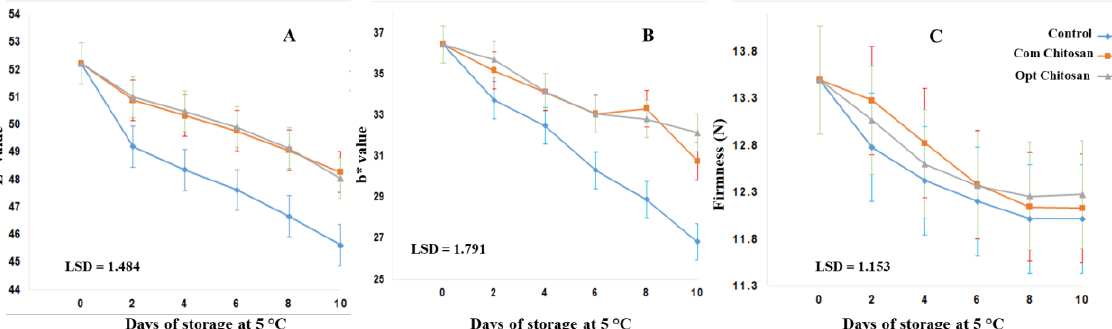
Figure 5. Color changes (L* ( A ) and b* ( B ) values) and firmness ( C ) during storage at 5 °C of papaya slices previously dipped in a chitosan solution. Control = fresh-cut papaya slices without application of chitosan film; Quit Com = fresh-cut papaya slices with application of commercial chitosan film; Quit Opt = fresh-cut papaya slices with application of chitosan film obtained under optimized lactic fermentation conditions. Each point represents the mean of 15 replicates. Vertical bars indicate LSD ( p ≤ 0.05).